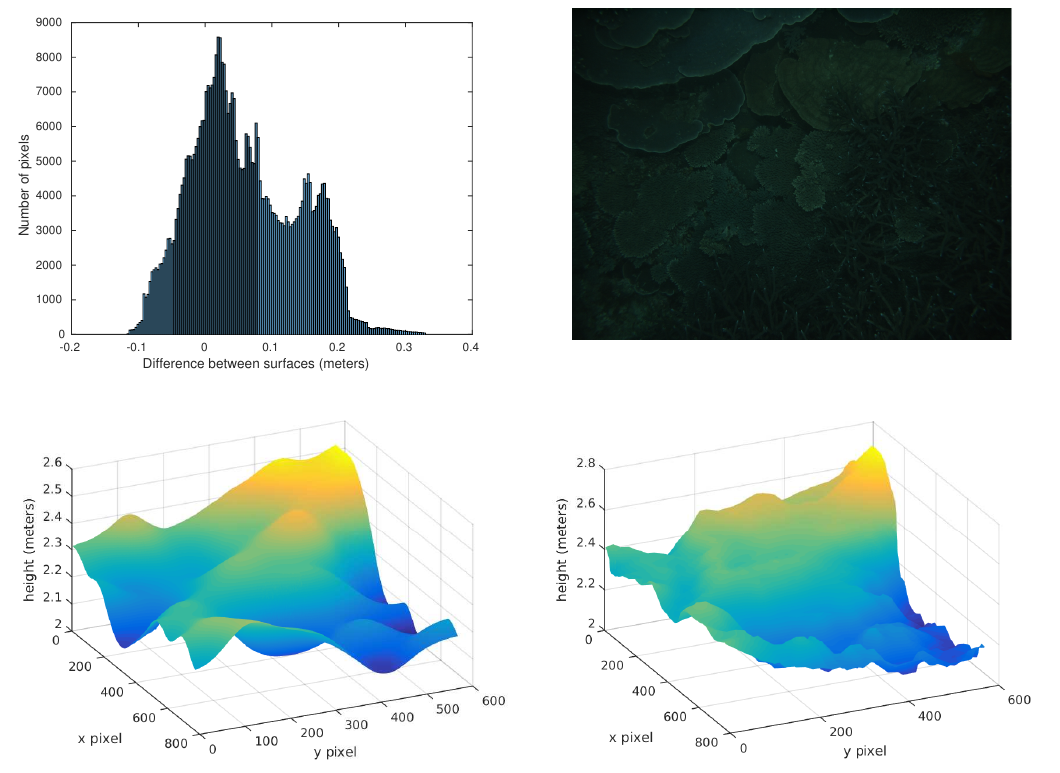
Figure 4. Visual metrics and evaluation: ( top right ) Visualization of the image, ( top left ) error histogram, (bottom right) “true” depthmap surface and ( bottom left ) neural network estimation